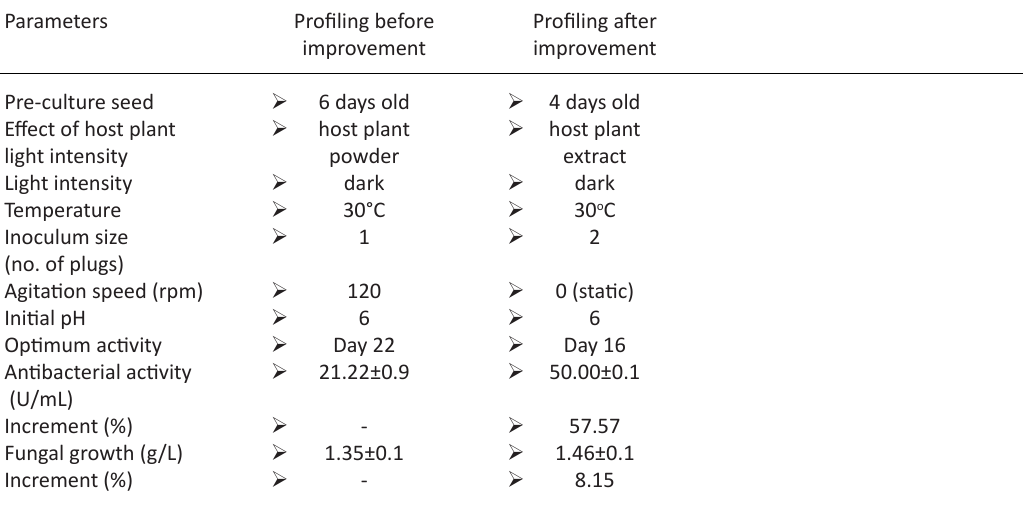
Table 1. Summary of the anti-MRSA activity and fungal growth production by L. pseudotheobromae IBRL OS-64 after improvement of physical parameters in a submerged fermentation using a shake flask system